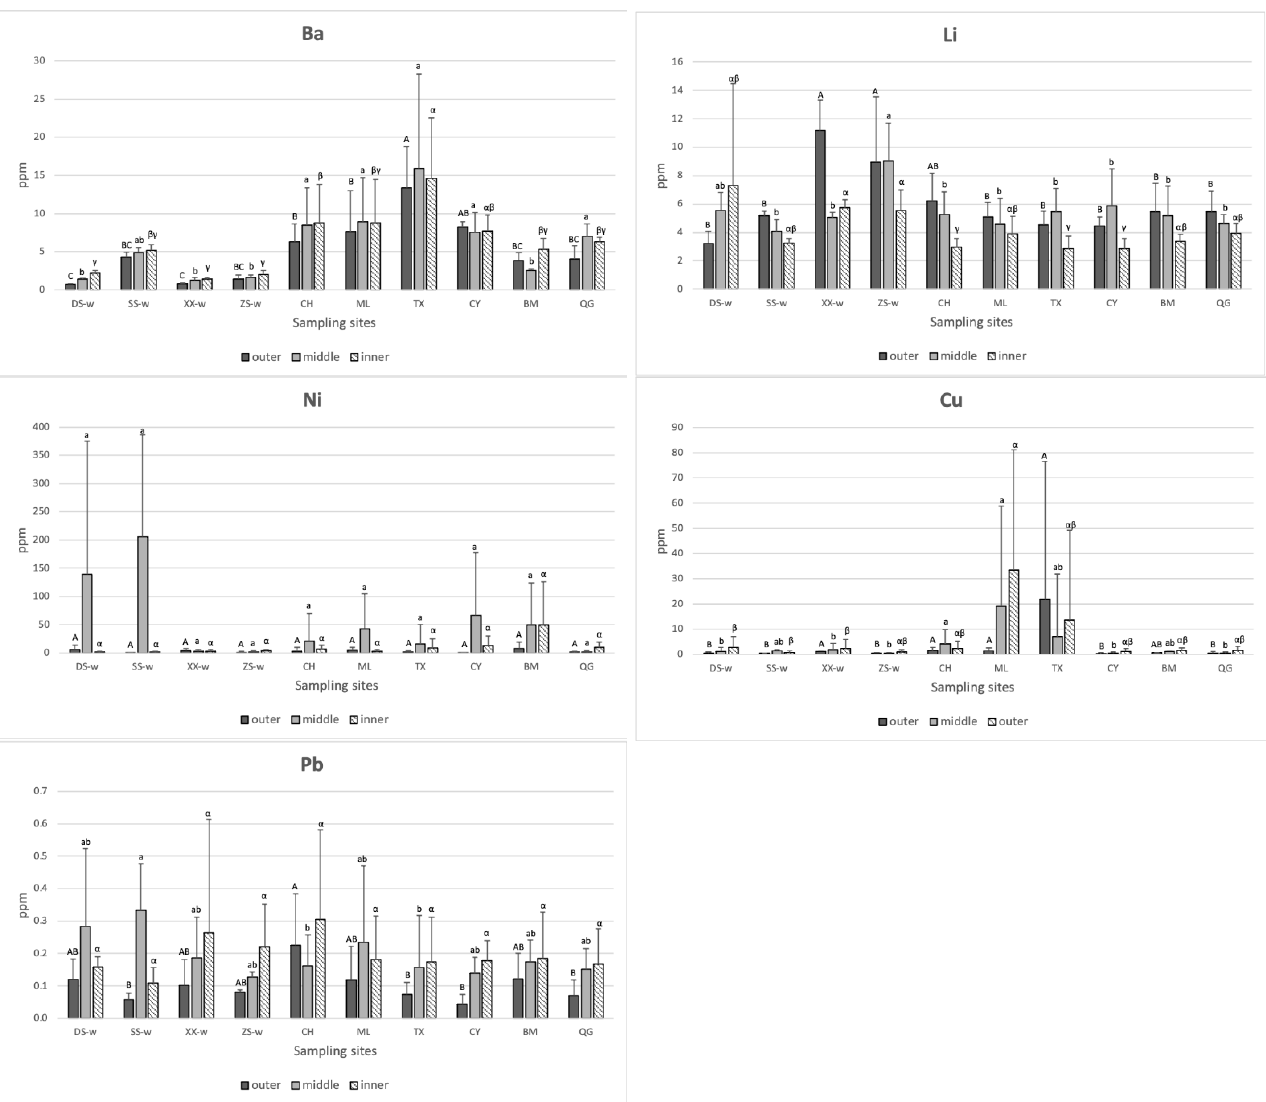
Figure 3. The 13 trace elements in the outer, middle, and inner site of the shells. All the results were represented as mean ± standard deviation (SD). Different capital letters among the groups indicate that an element differed significantly ( p < 0.05) in the outer; different lower case letters among the groups indicate that an element differed significantly ( p < 0.05) in the middle; different Greek alphabet letters among the groups indicate that an element differed significantly ( p < 0.05) in the inner.